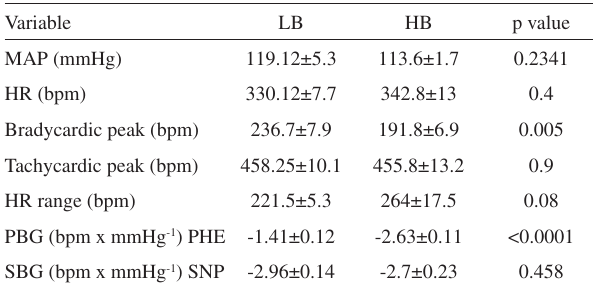
parasympathetic component of baroreflex gain, but not in the other parameters, were observed. Table 1- Baseline mean arterial pressure (MAP) and heart rate (HR), bradycardic and tachycardic peaks, HR range, para- sympathetic (PBG) and sympathetic baroreflex gain (SBG) in HB (n=14) and LB (n=8) groups. Mean±SEM.